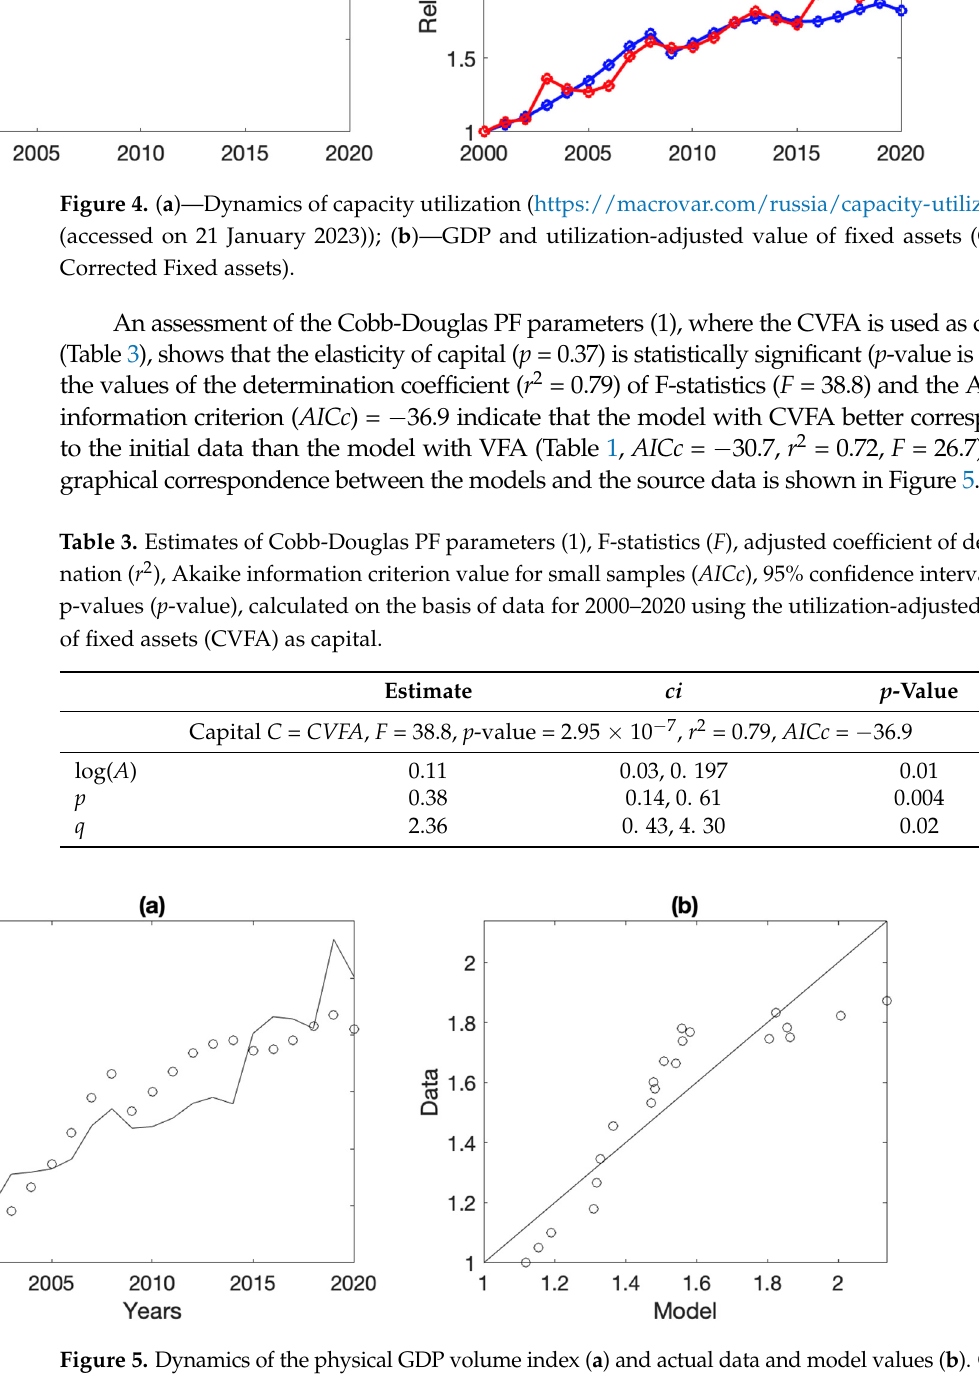
Figure 5. Dynamics of the physical GDP volume index ( a ) and actual data and model values ( b ). Circles denote actual data, black line is values obtained according to the Cobb-Douglas PF (1) with parameters from Table 1, where the utilization-adjusted value of fixed assets (CVFA) is used as capital C